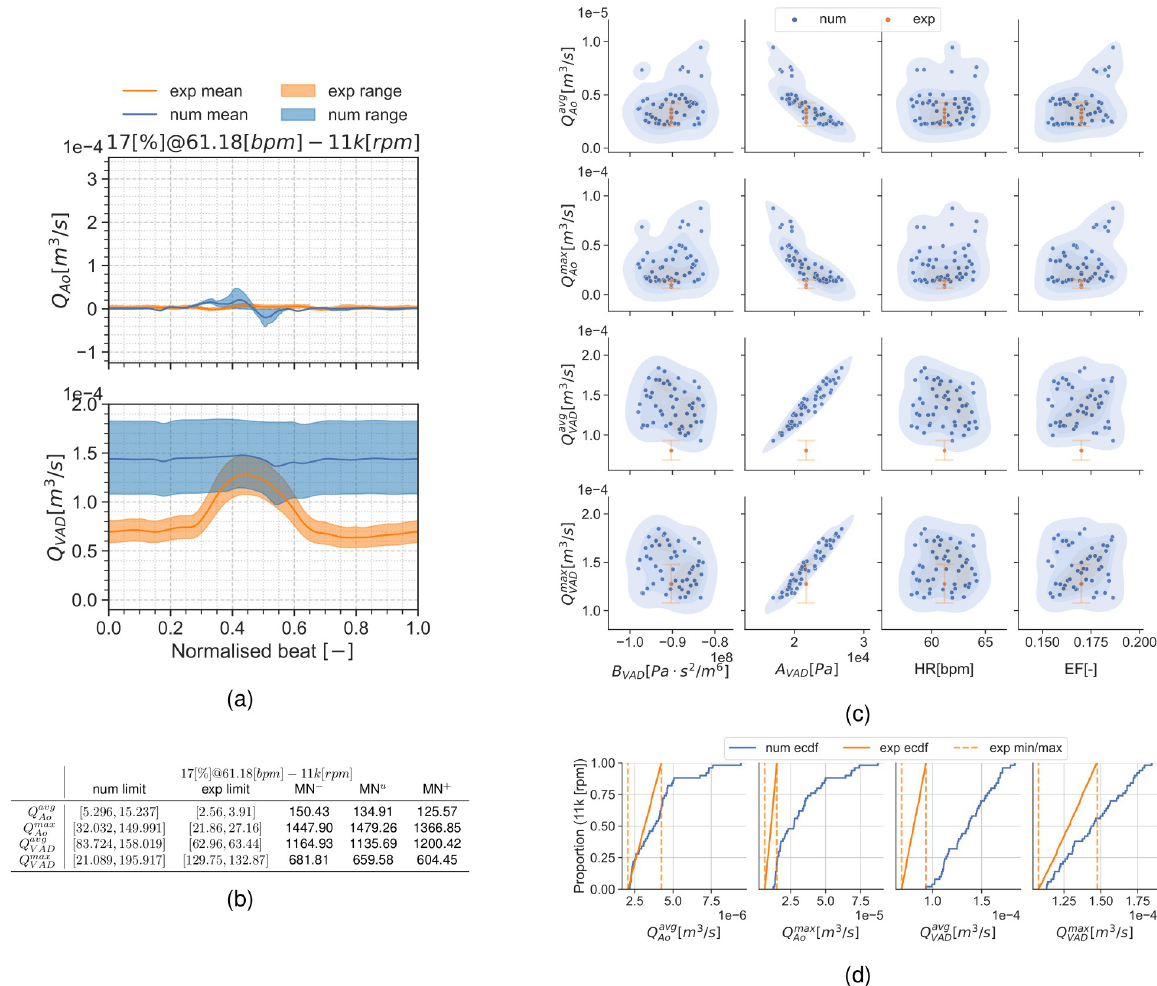
Fig 11. Summary for the condition 17[%]@61.18[ bpm ] and 11 k [ rpm ]. (a): aortic valve and LVAD flows. (b): validation metrics. (c): scatter plot showing the simulation aned experimental data. (d): ECDF for the simulation, experimental data limits and the constructed uniform